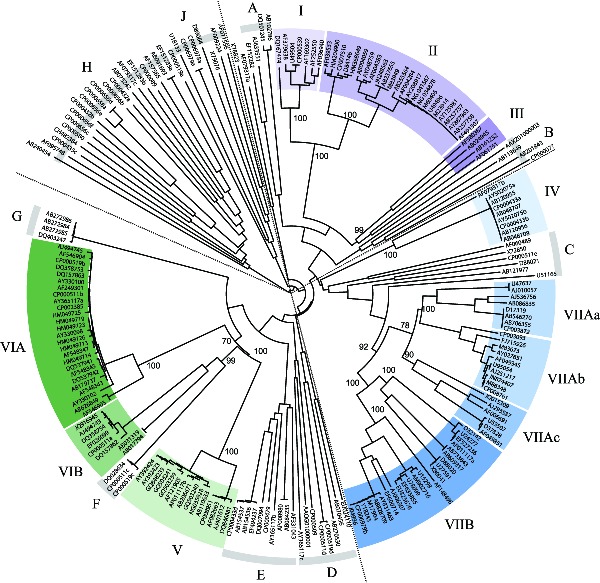
Our study aimed to re-evaluate the phylogeny of Rieske non-heme iron dioxygenases using only retrieved primary nucleic acid sequences for the development of quantitative real-time PCR primers.